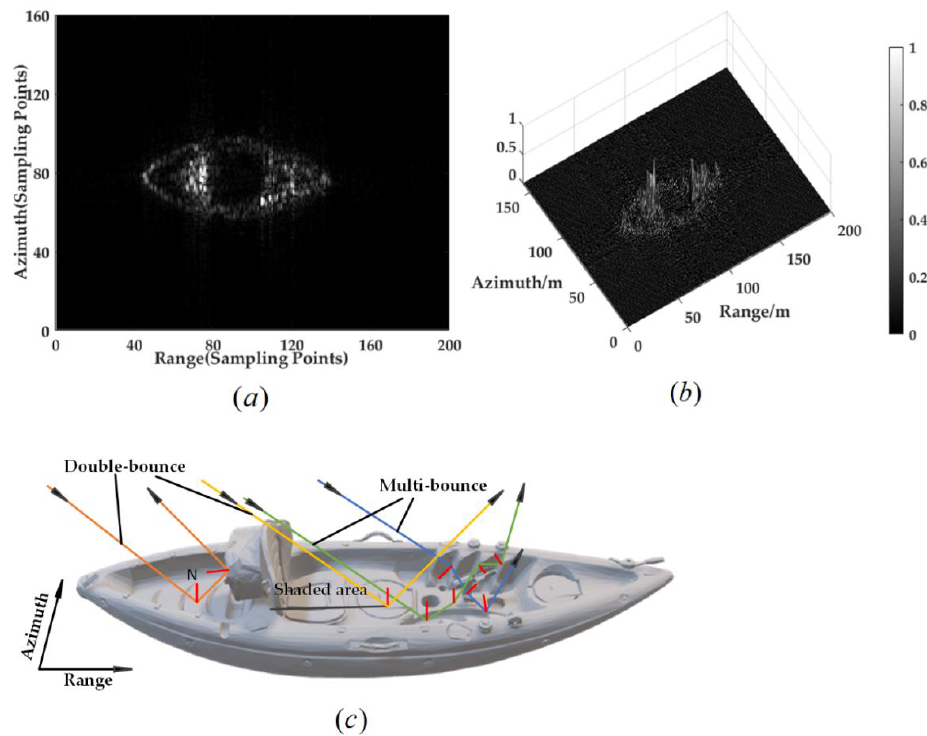
Figure 15. Simulated SAR image of the assault boat: ( a ) magnitude image; ( b ) energy distribution; ( c ) scattering path analysis.